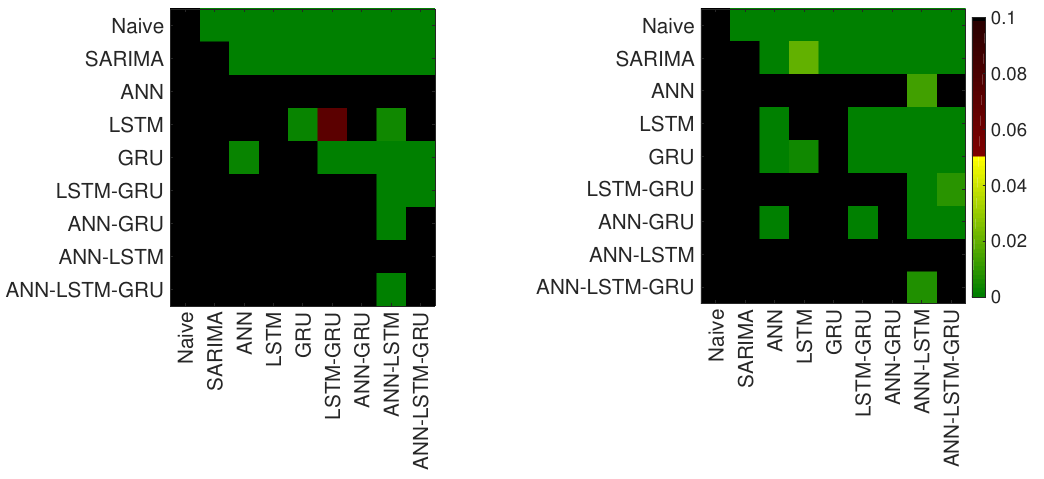
Figure 6. Results of the Diebold-Mariano tests defined by the MAE values and profit loss differential series in between different models. The figure indicates the statistical significance (green) for which the forecasts of a model on the X-axis are significantly better than those of a model on the Y-axis. The statistical significance of the difference between the MAE values does not translate fully into a difference in Profit